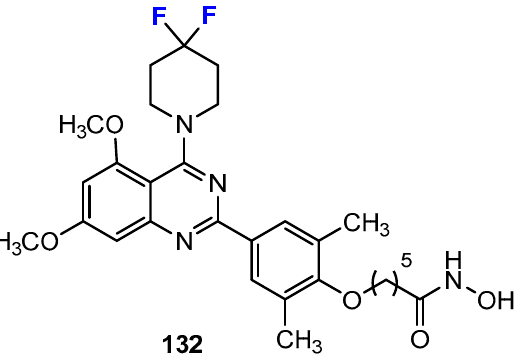
Figure 5. Chemical structure of fluorinated hydroxamic acid by Yao, Li et al. [70]. Gawel, Shouksmith, Raouf, Nawar, and co-workers [71] described some HDACis be-